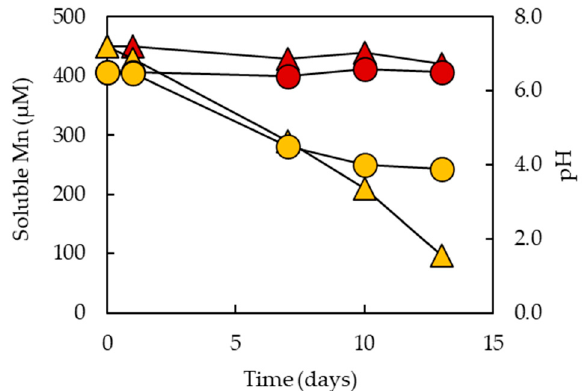
Figure 9. Changes in soluble manganese concentrations ( ▲ , ▲ ) and pH ( ● , ● ) in shake flasks cul- tures inoculated with isolate MnI1 ( ▲ , ● ) and noninoculated controls ( ▲ , ● ) with isolate MnI1. The experiment was carried out in duplicate and different values between replicates are occluded by the symbols.